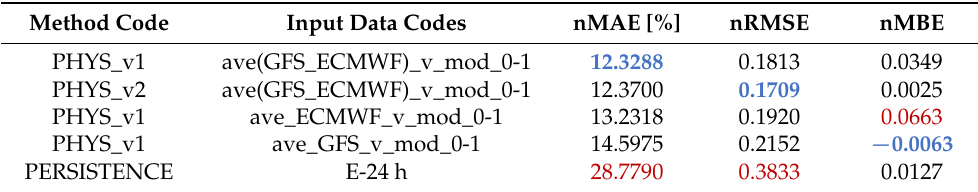
Table 5. Measures of performance of the proposed Physical Models (test subset) for Wind Farm A. Method Code